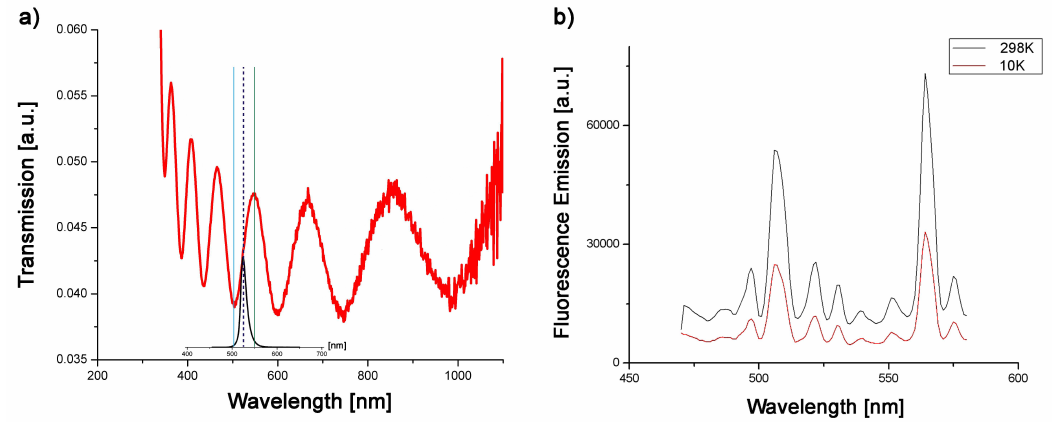
Figure 7. ( a ) Optical response of the cavity with emission spectrum from perovskite fluorophores in solution (inset); ( b ) emission spectrum from perovskite fluorophores in cavity—signature of Rabi splitting.